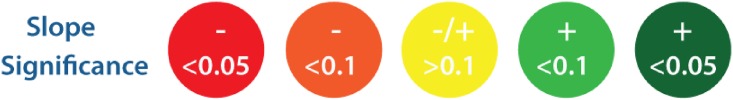
Legend used to interpret the scorecard produced by MAREA.Colors indicate direction of change (red = negative; green = positive), and color intensity is given by the statistical significance.